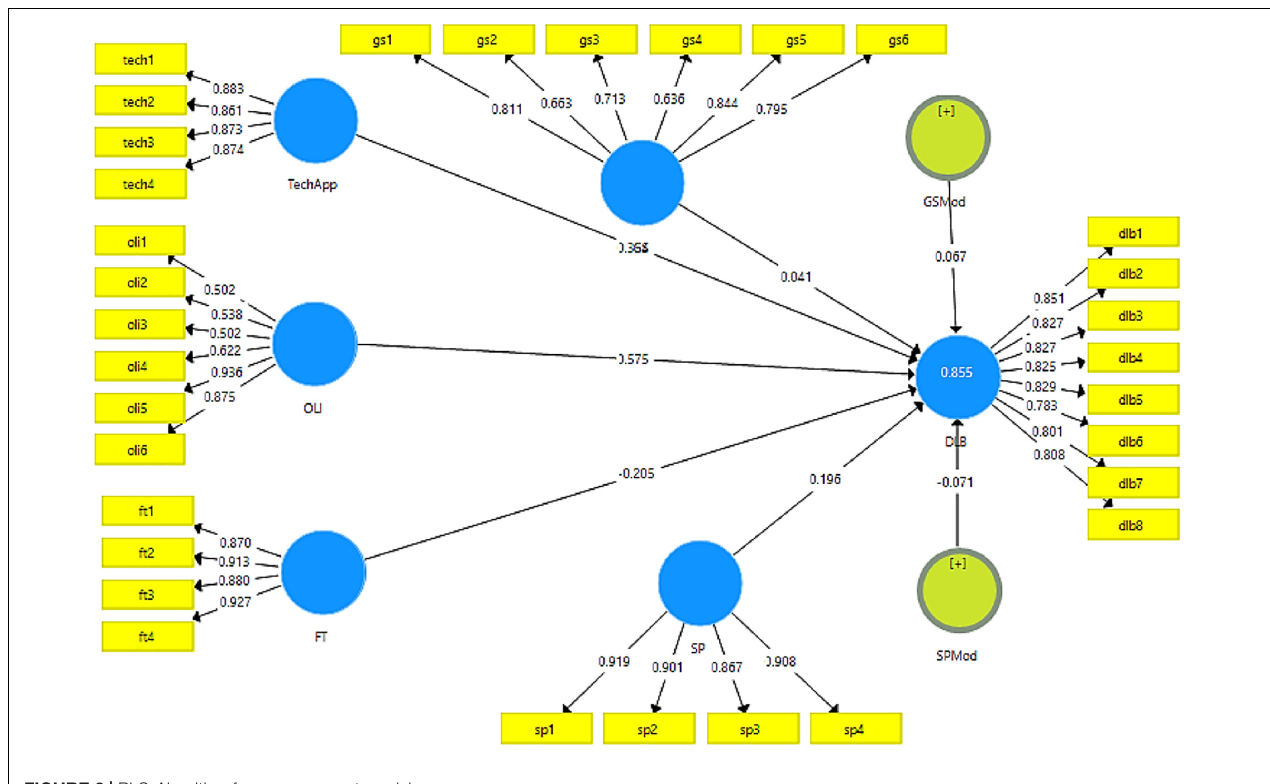
FIGURE 2 | PLS-Algorithm for measurement model. TABLE 3 | Fornell and larcker criterion.